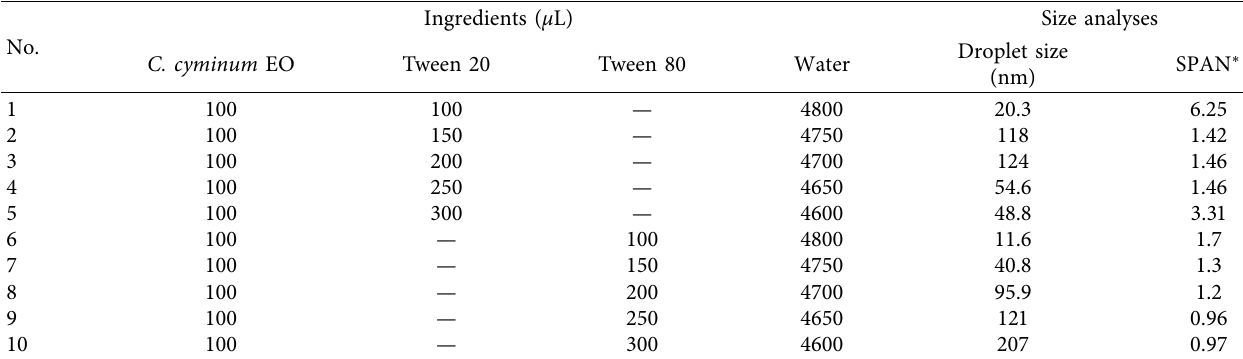
Table 2: Prepared nanoemulsions: ingredients and size analyses.